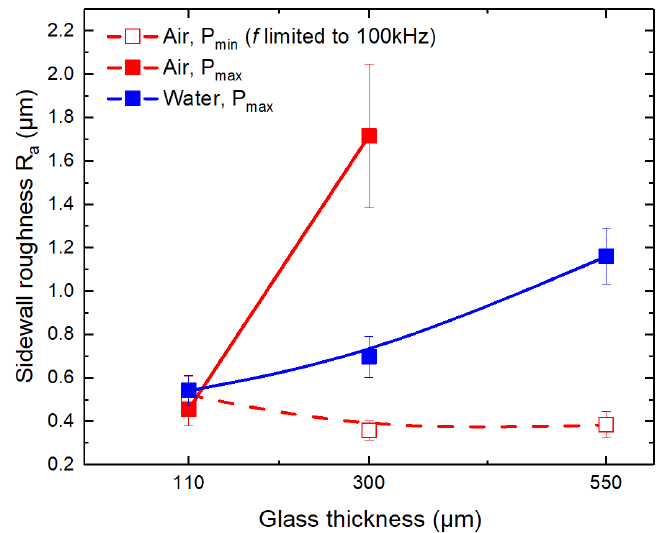
Figure 8. Cut-sidewall roughness versus glass thickness. Glass strips were cut in ambient air and water environments. Dots are connected to guide the eye, while error bars indicate the standard